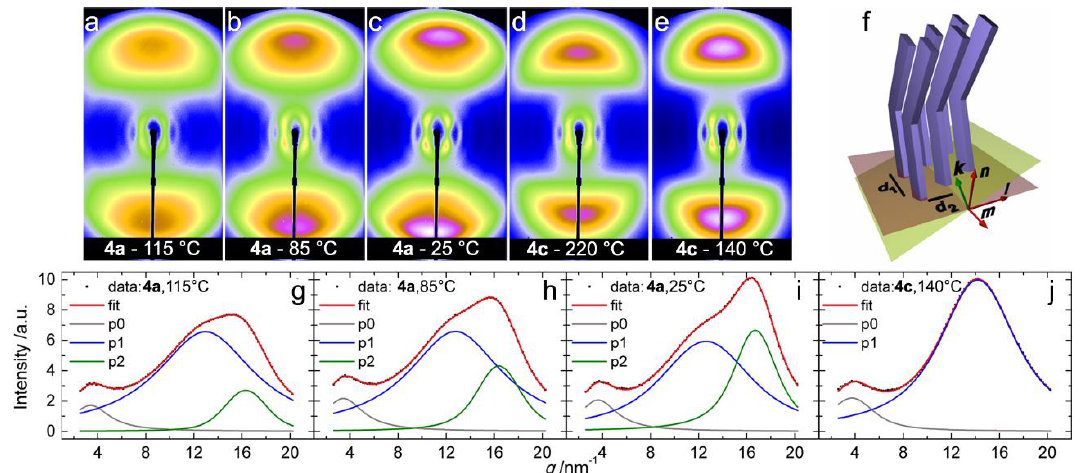
Figure 12. ( a–e ) Wide-angle XRD patterns for BCMs 4a ( a – c ) and 4c ( d , e ) at selected temperatures under a horizontal magnetic field B (‖ n ); patterns (b,c,e) are in the supercooled N phase. ( f ) Schematic drawing of molecular packing within a tilted cybotactic cluster: k indicates the normal to the Sm plane (green), n , m , and l are the three orthogonal molecular directors; d 1 and d 2 are the intermolecular distances in the plane normal to n (purple). ( g – j ) Fit of the wide-angle equatorial (vertical) intensity profiles with two, p1 and p2, ( g – i ) or one, p1, ( j ) Voigt lineshapes (an additional small peak, p0, is added in the low-angle region to model peripheral scattering from the four-spot feature): ( g ) 4a at 115 ◦ C, ( h ) 4a at 85 ◦ C, ( i ) 4a at 25 ◦ C, and ( j ) 4c at 140 ◦ C. Reprinted (adapted) with permission from [49]. Copyright 2014 American Chemical Society.